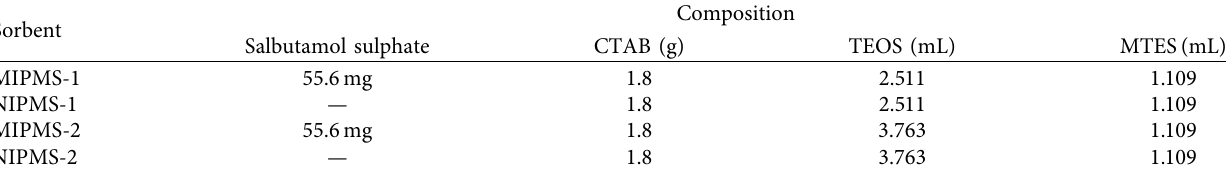
Table 1: Composition of materials used in the synthesis of MIPMS and